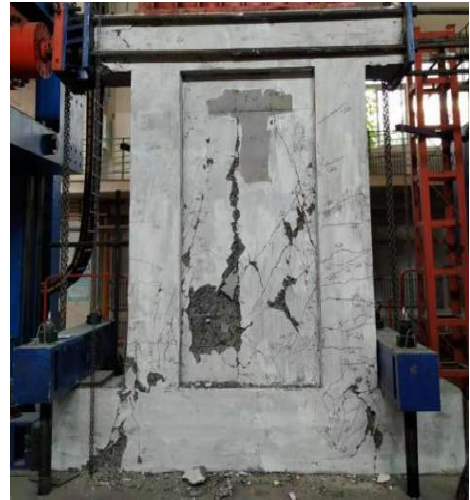
Figure 7. Final damage of specimen XJ.